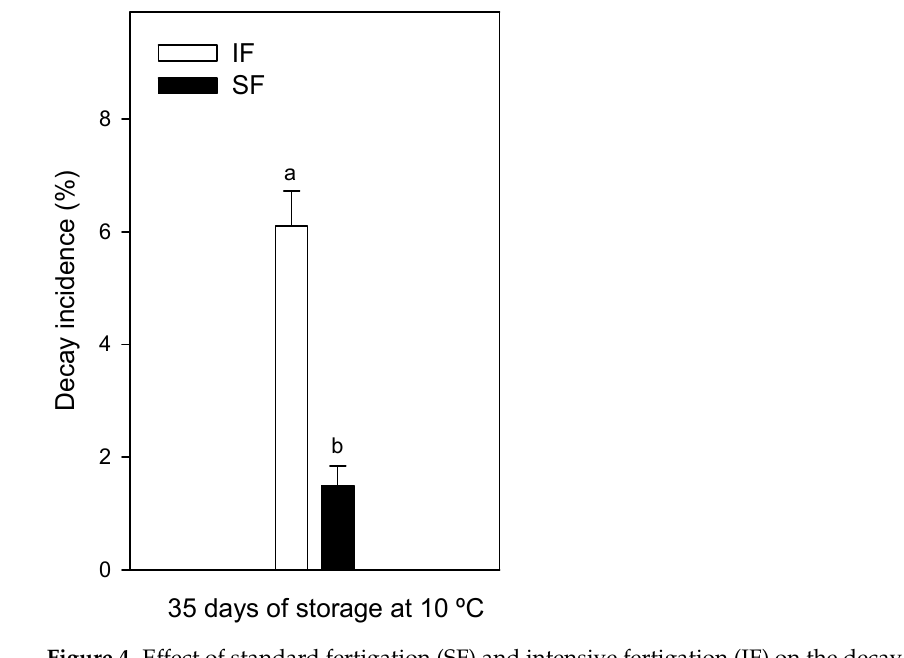
Figure 4. Effect of standard fertigation (SF) and intensive fertigation (IF) on the decay incidence of lemon fruits. Lowercase letters indicate significant differences between lemon fruits cultivated with IF and those with SF at p < 0.05.